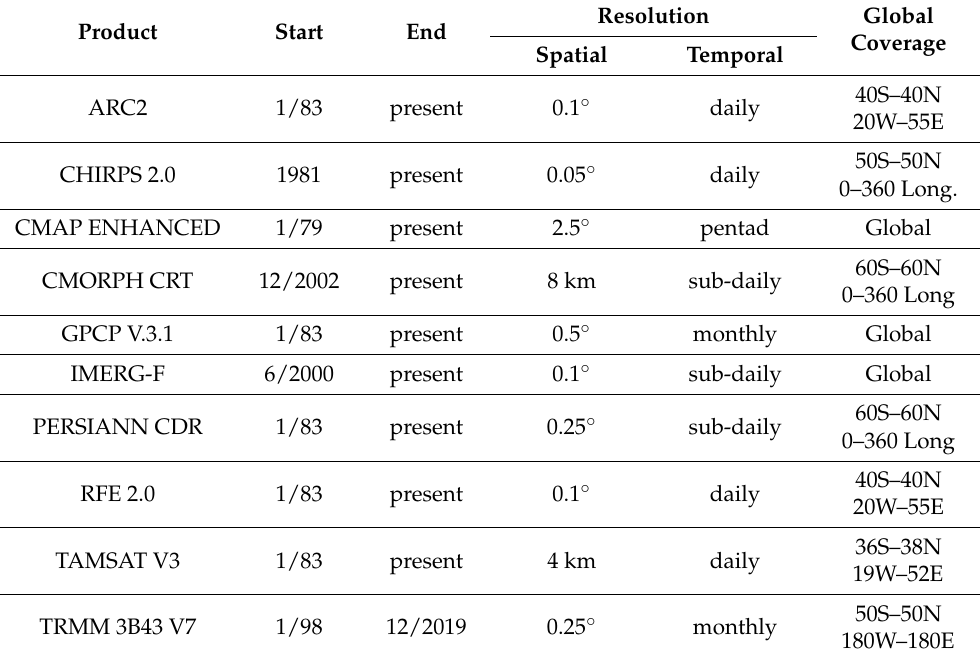
Table 1. The satellite rainfall products evaluated in this